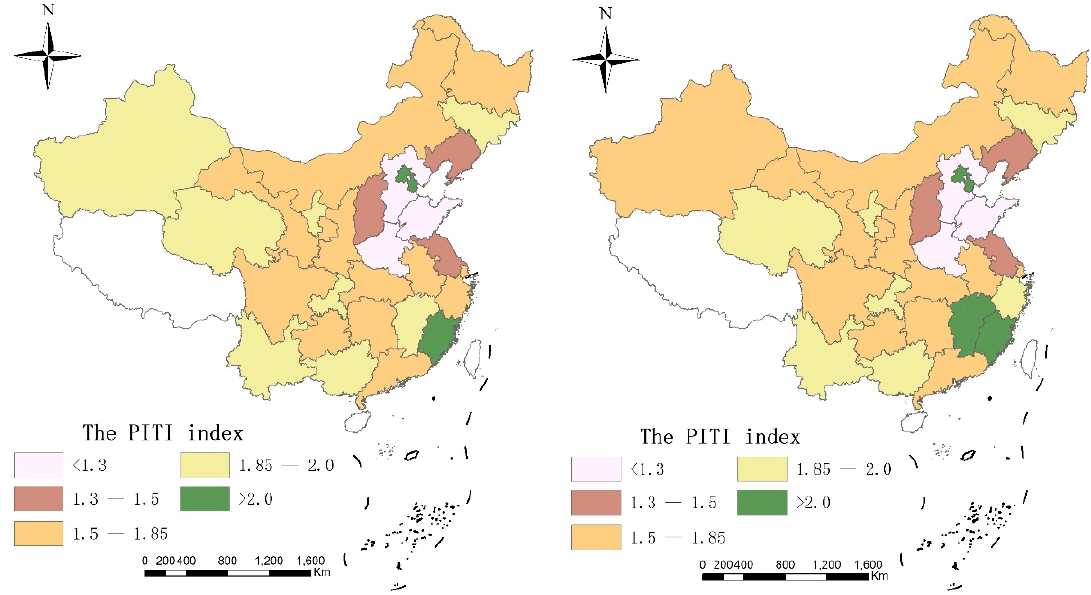
Figure 1. Spatio ‐ temporal differentiation of China’s PITI index from 2010 to 2018. Figure 1. Spatio-temporal differentiation of China’s PITI index from 2010 to